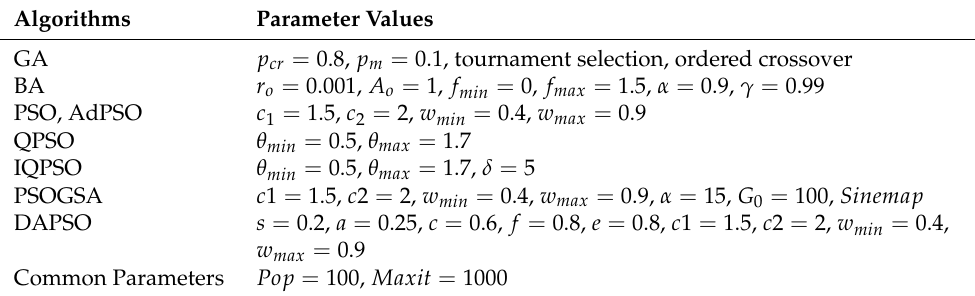
Table 3. Parameter settings of the